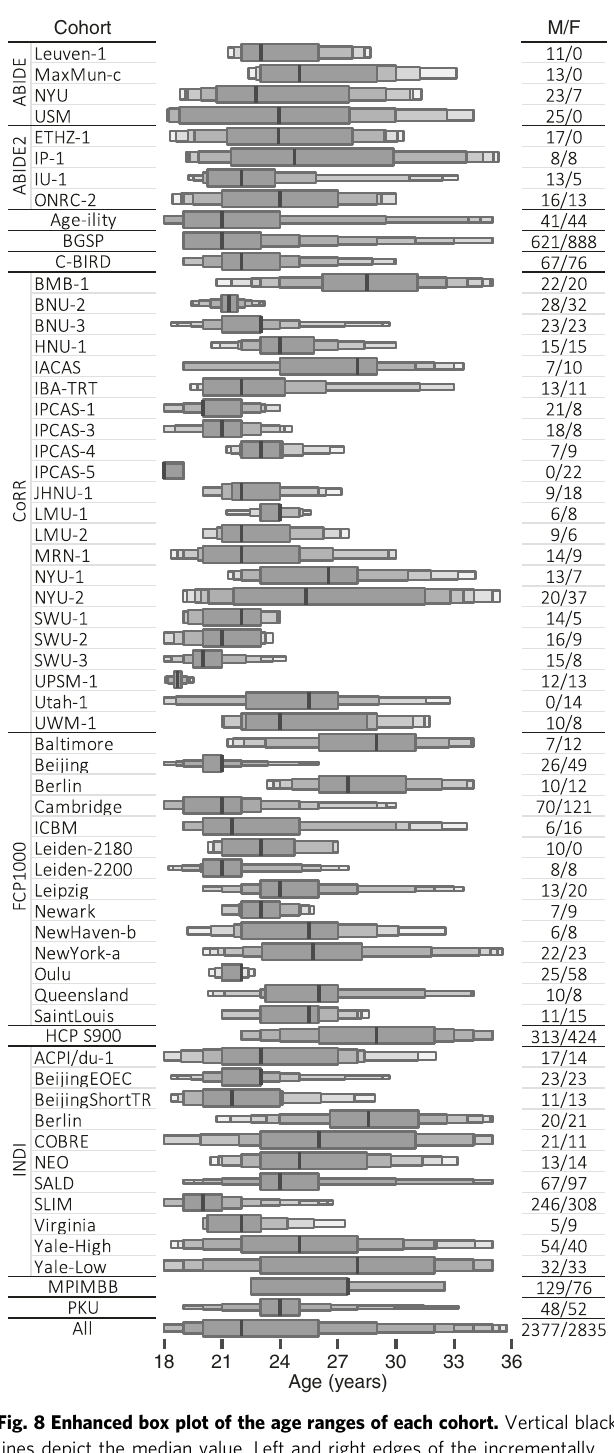
Fig. 8 Enhanced box plot of the age ranges of each cohort. Vertical black lines depict the median value. Left and right edges of the incrementally narrower boxes depict the lower and upper fourths, eighths, sixteenths, etc. M/F